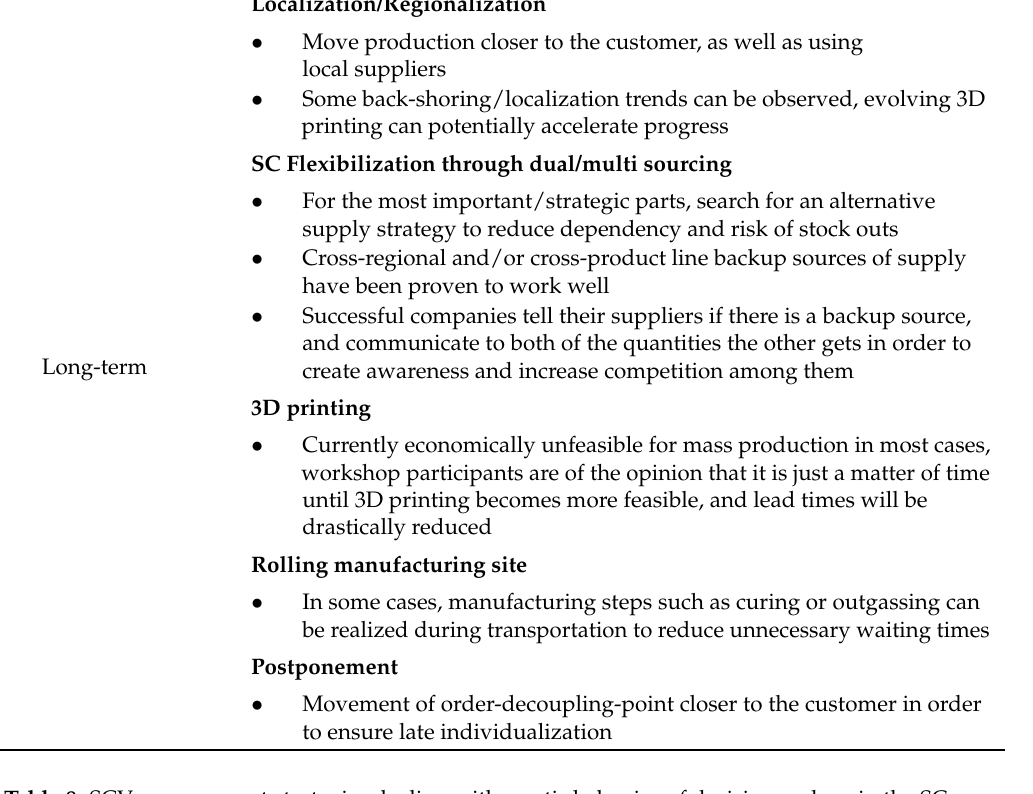
Table 8. SCV management strategies dealing with erratic behavior of decision makers in the SC. Time